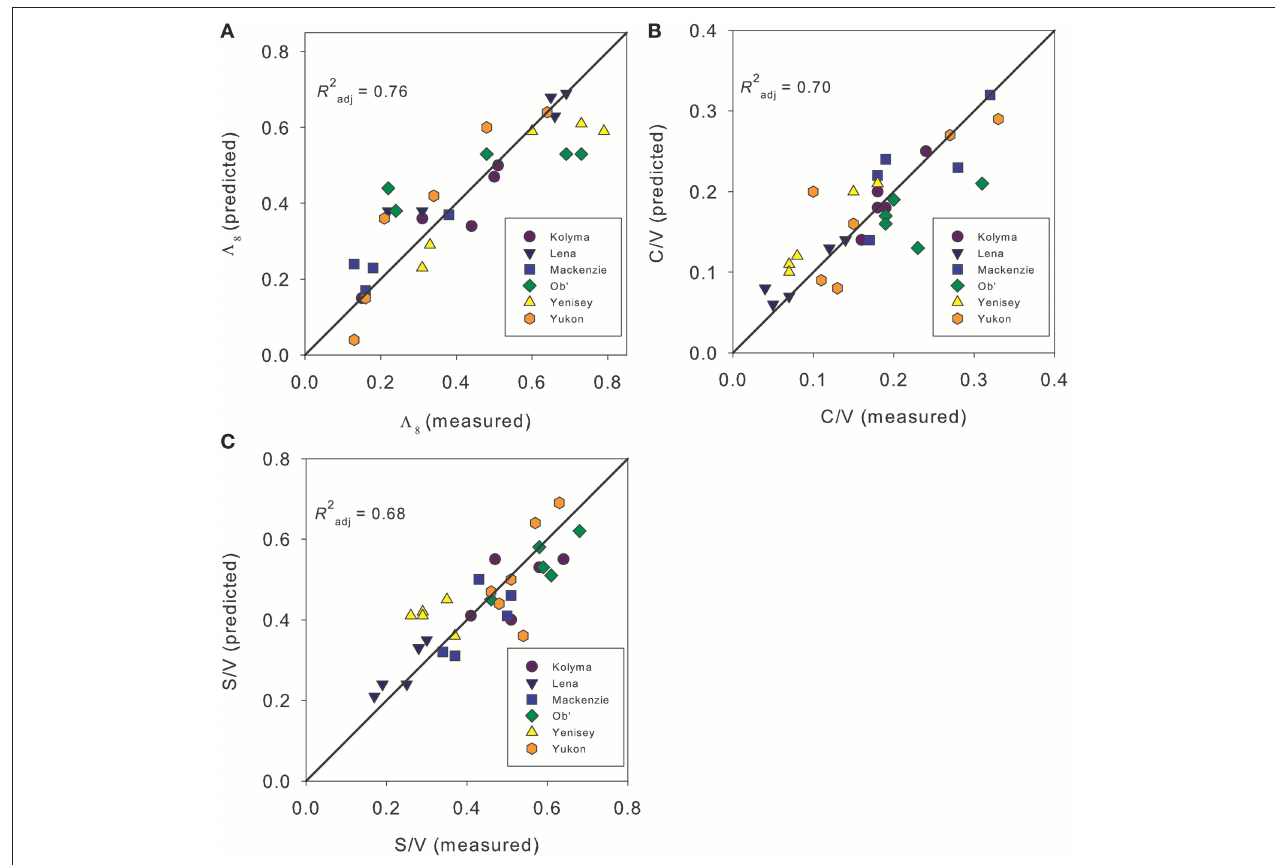
FIGURE 6 | Model predicted values against observed measurements of (A). Carbon normalized sum of the lignin phenols [ 3 8 ; mg (100mg OC) − 1 ], (B) Cinnamyl to vanillyl phenol ratios (C/V), and (C) Syringyl to vanillyl phenol ratios (S/V).